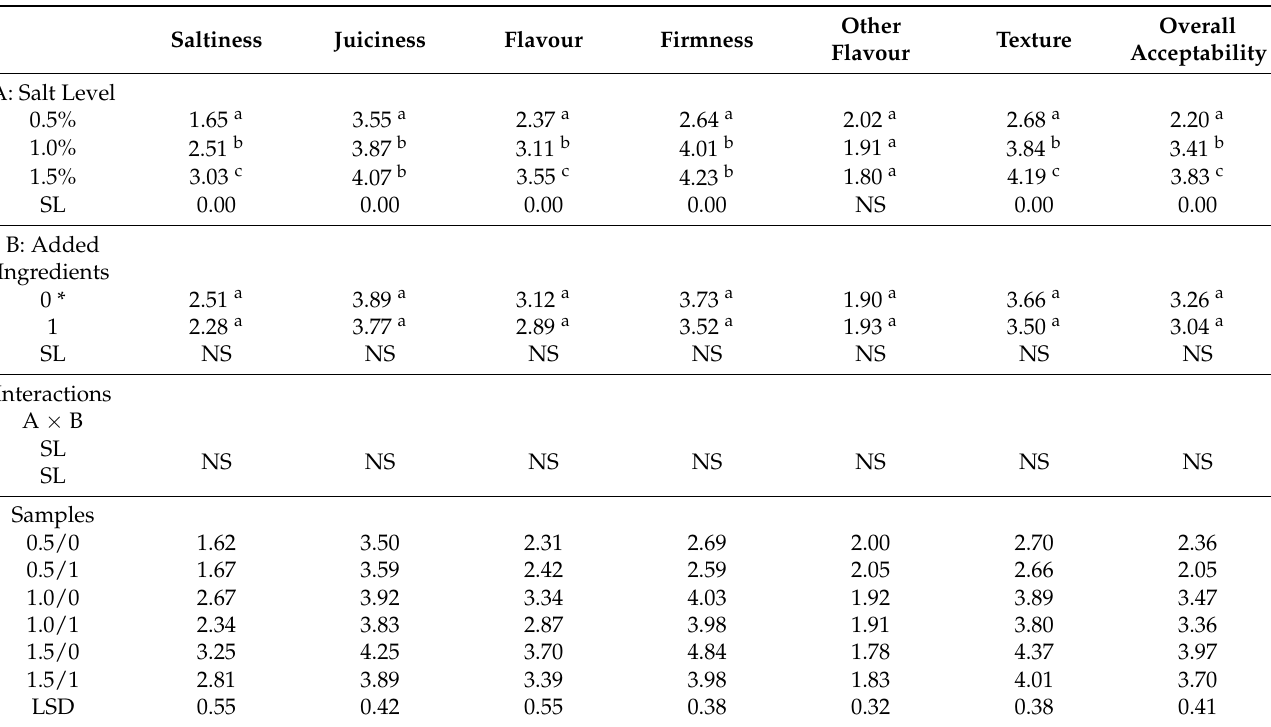
Table 4. The effect of salt levels and added ingredients KCl \ TS on the sensory properties of breakfast sausages manufactured with pork belly meat high pressure treated at 150